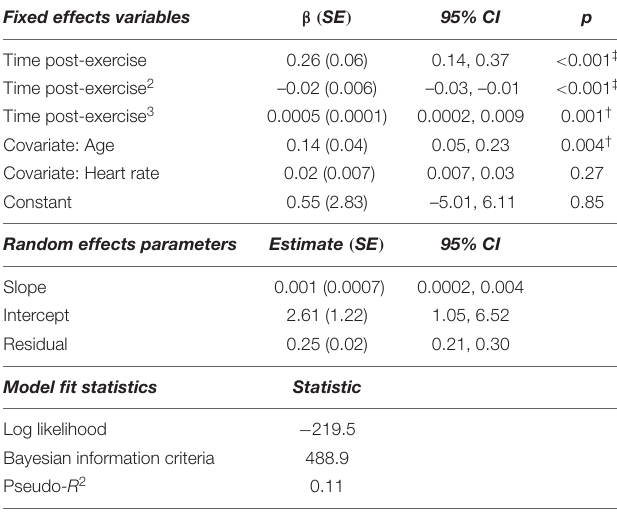
TABLE 3 | Mixed model analyses on changes in central hemodynamics after peak aerobic exercise. (A) Heart rate ( n = 10, 255